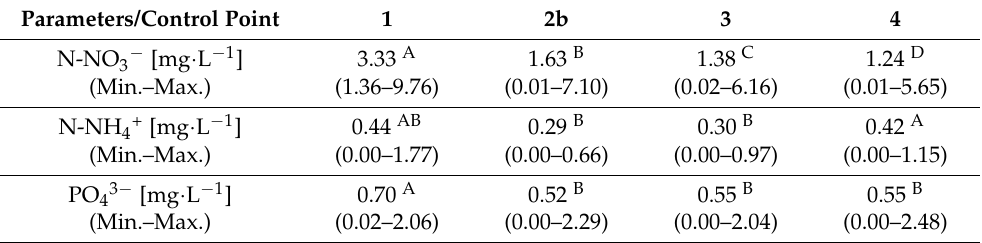
Table 2. Characteristics of the concentration of nutrients in water which flows through the SED-BIO system. Different letters mean a significant difference between control sites for each parameter in the Wilcoxon signed-rank test with p < 0.05, n = 36.